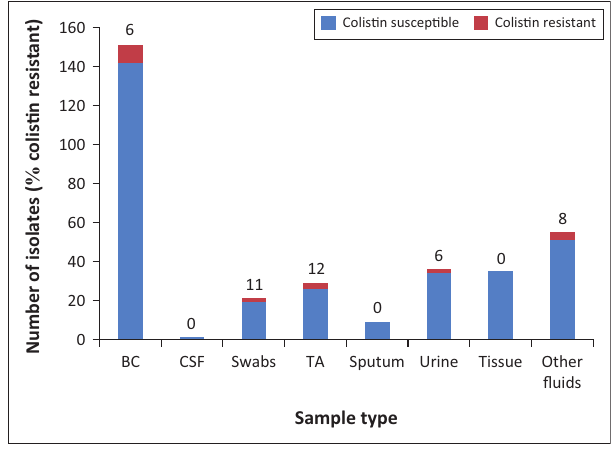
FIGURE 2: Distribution of colistin-resistant and susceptible XDR A. baumannii complex isolates by sample type ( n =